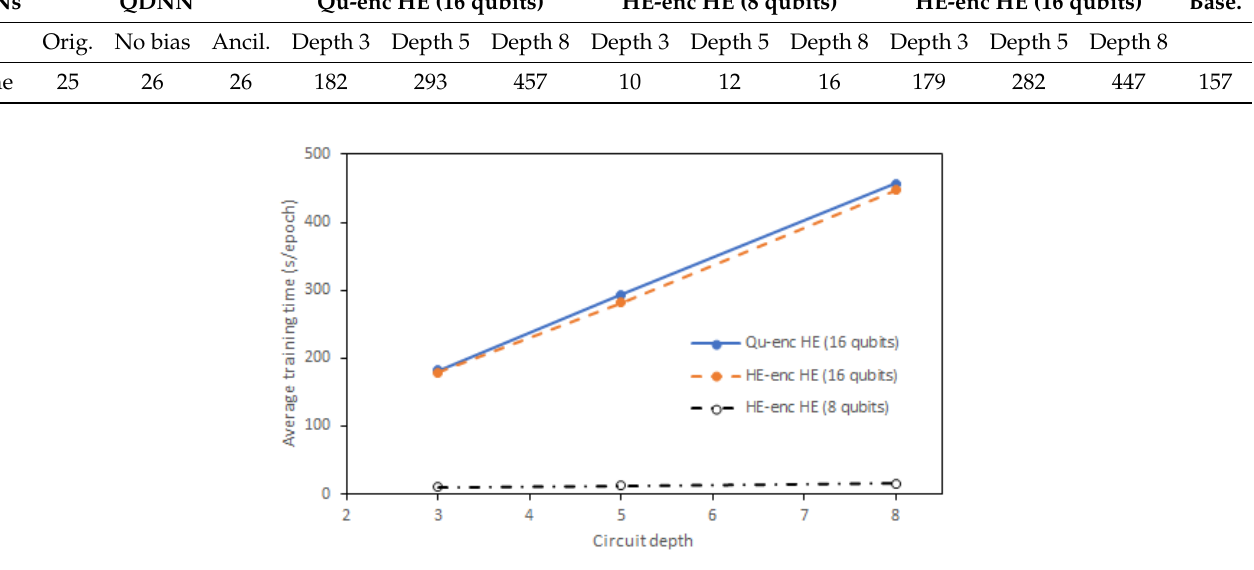
Figure 11. Relationship of training time and circuit